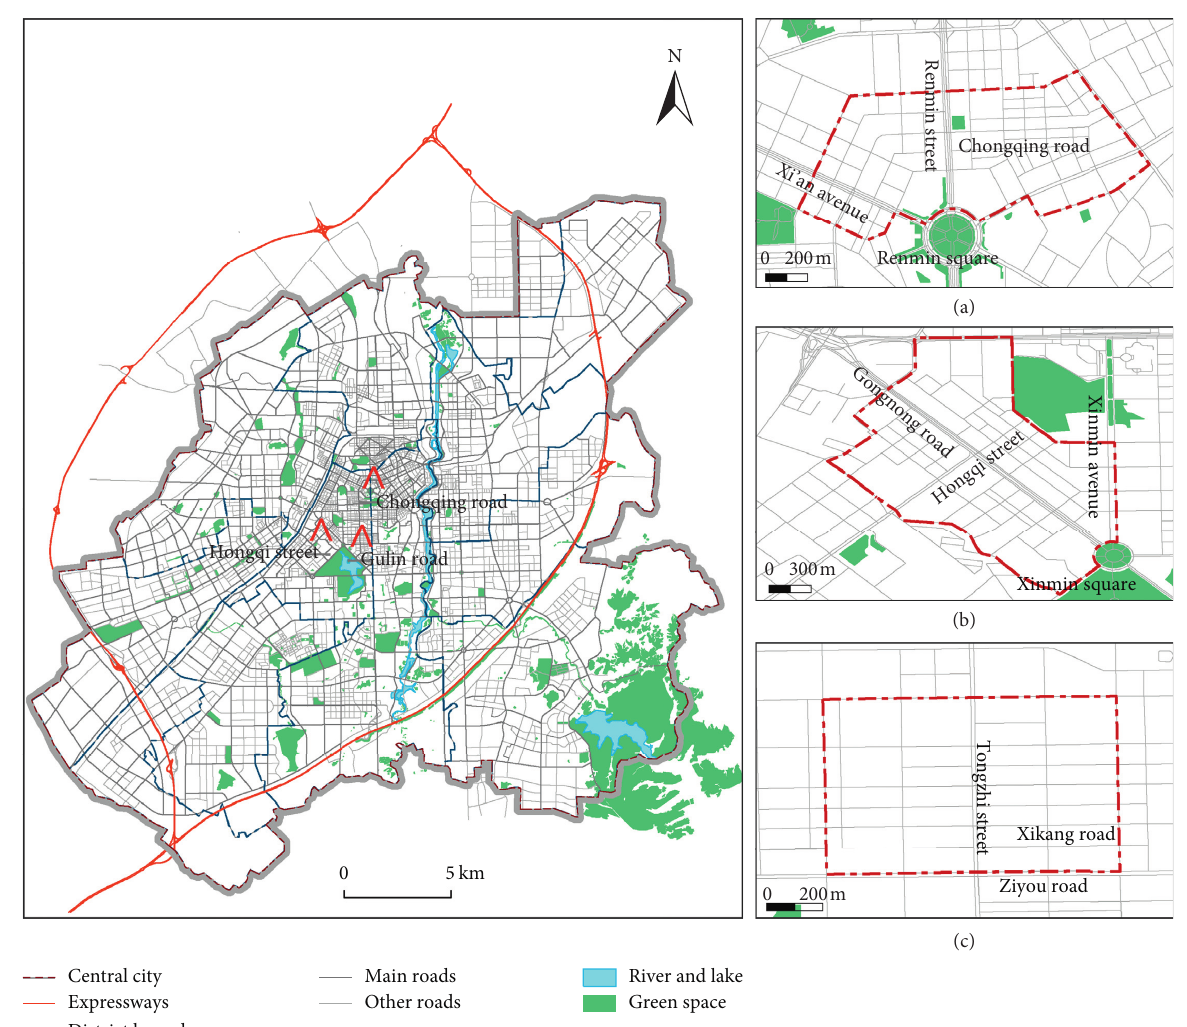
Figure 1: Study area and distribution of the commercial districts in Changchun: (a) Chongqing Road; (b) Hongqi Road; (c) Guilin